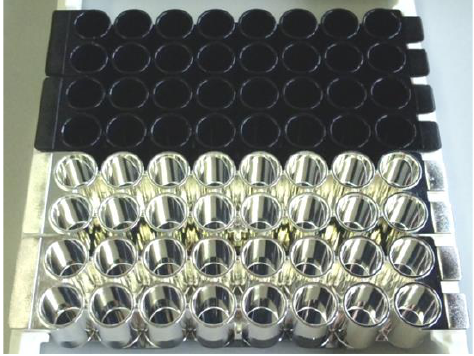
Figure 3. Modules of unmodified (upper) and multilayered (lower) microplates modified with a 200-nm-thick silver layer and coated with a 53-nm-thick HMDS PPF.